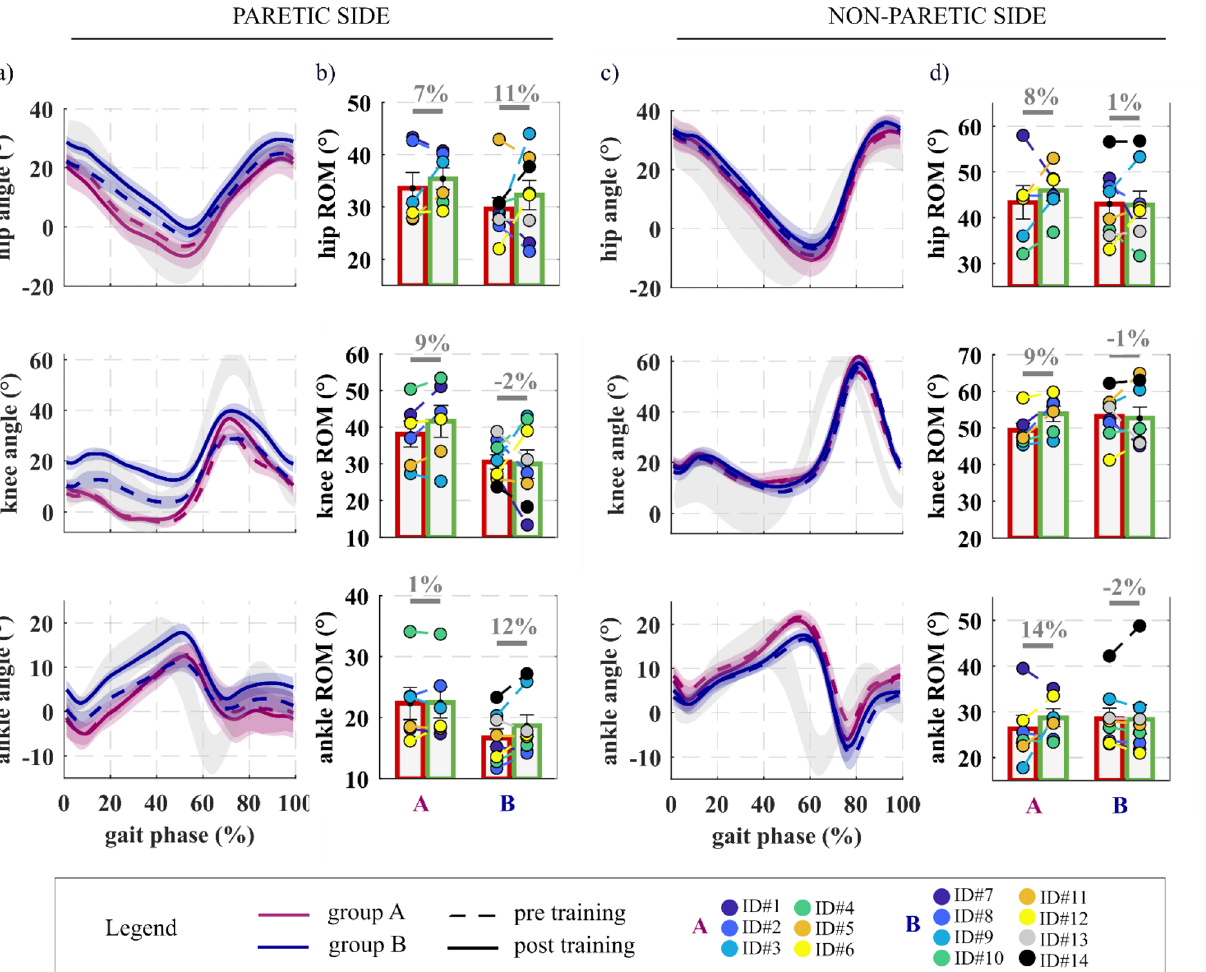
Figure 5. Lower-limb kinematics averaged across group participants pre and post training. Joint kinematic profiles and range of motion (ROM) of the paretic ( a,b ) and non-paretic ( c,d ) hip, knee and ankle joints measured during the pre-training (dashed lines) and post-training (solid lines) gait analysis for the group A (purple) and the group B (blue). Data are shown aggregated across group participants as mean ± standard errors (n = 6 group A, n = 8 group B). Circles represent individual study participants. Normative data for the hip, knee and ankle kinematic profiles are reported in light